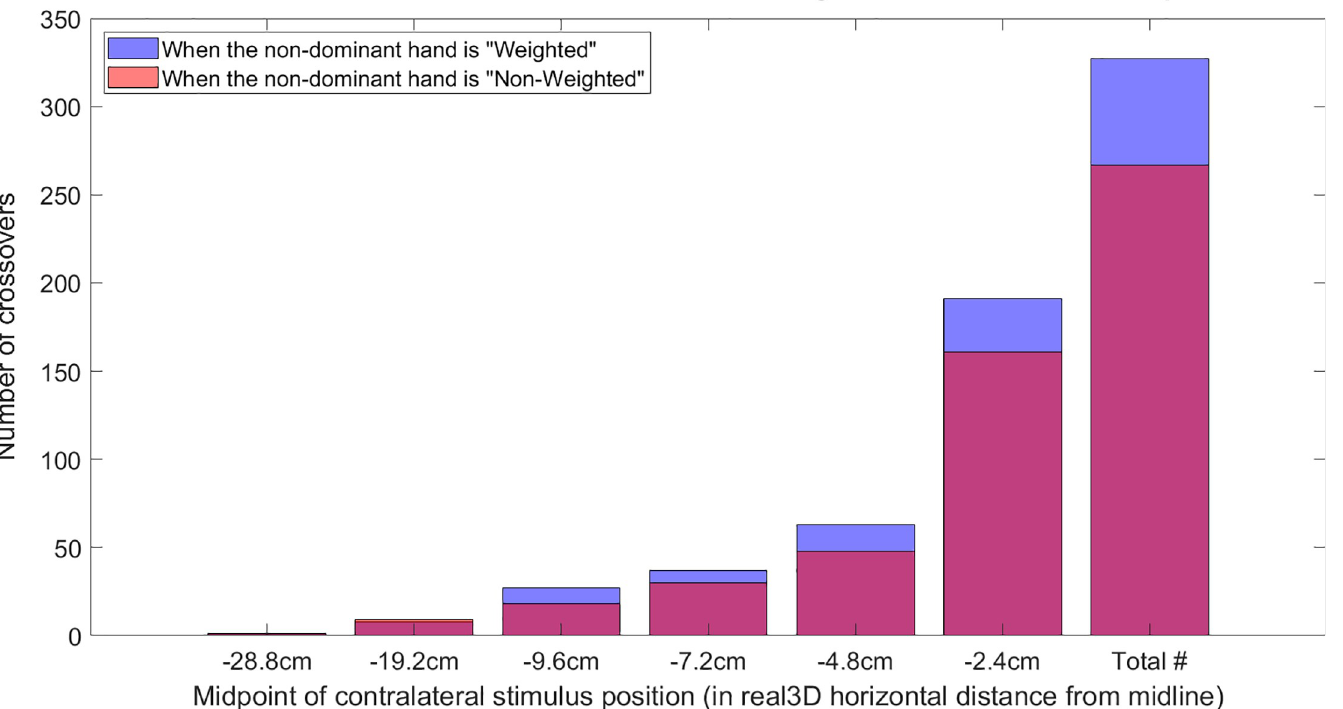
Fig 5. Spatial distributions of dominant (right) hand crossovers. Real 3D space horizontal stimulus positions of left-from-midline, contralateral target stimuli at the three heights positions have been summed up across the group; the red bars represent crossovers in the non-weighted condition, while the blue bars represent the dominant hand crossovers when a weighted-glove was on the non-dominant